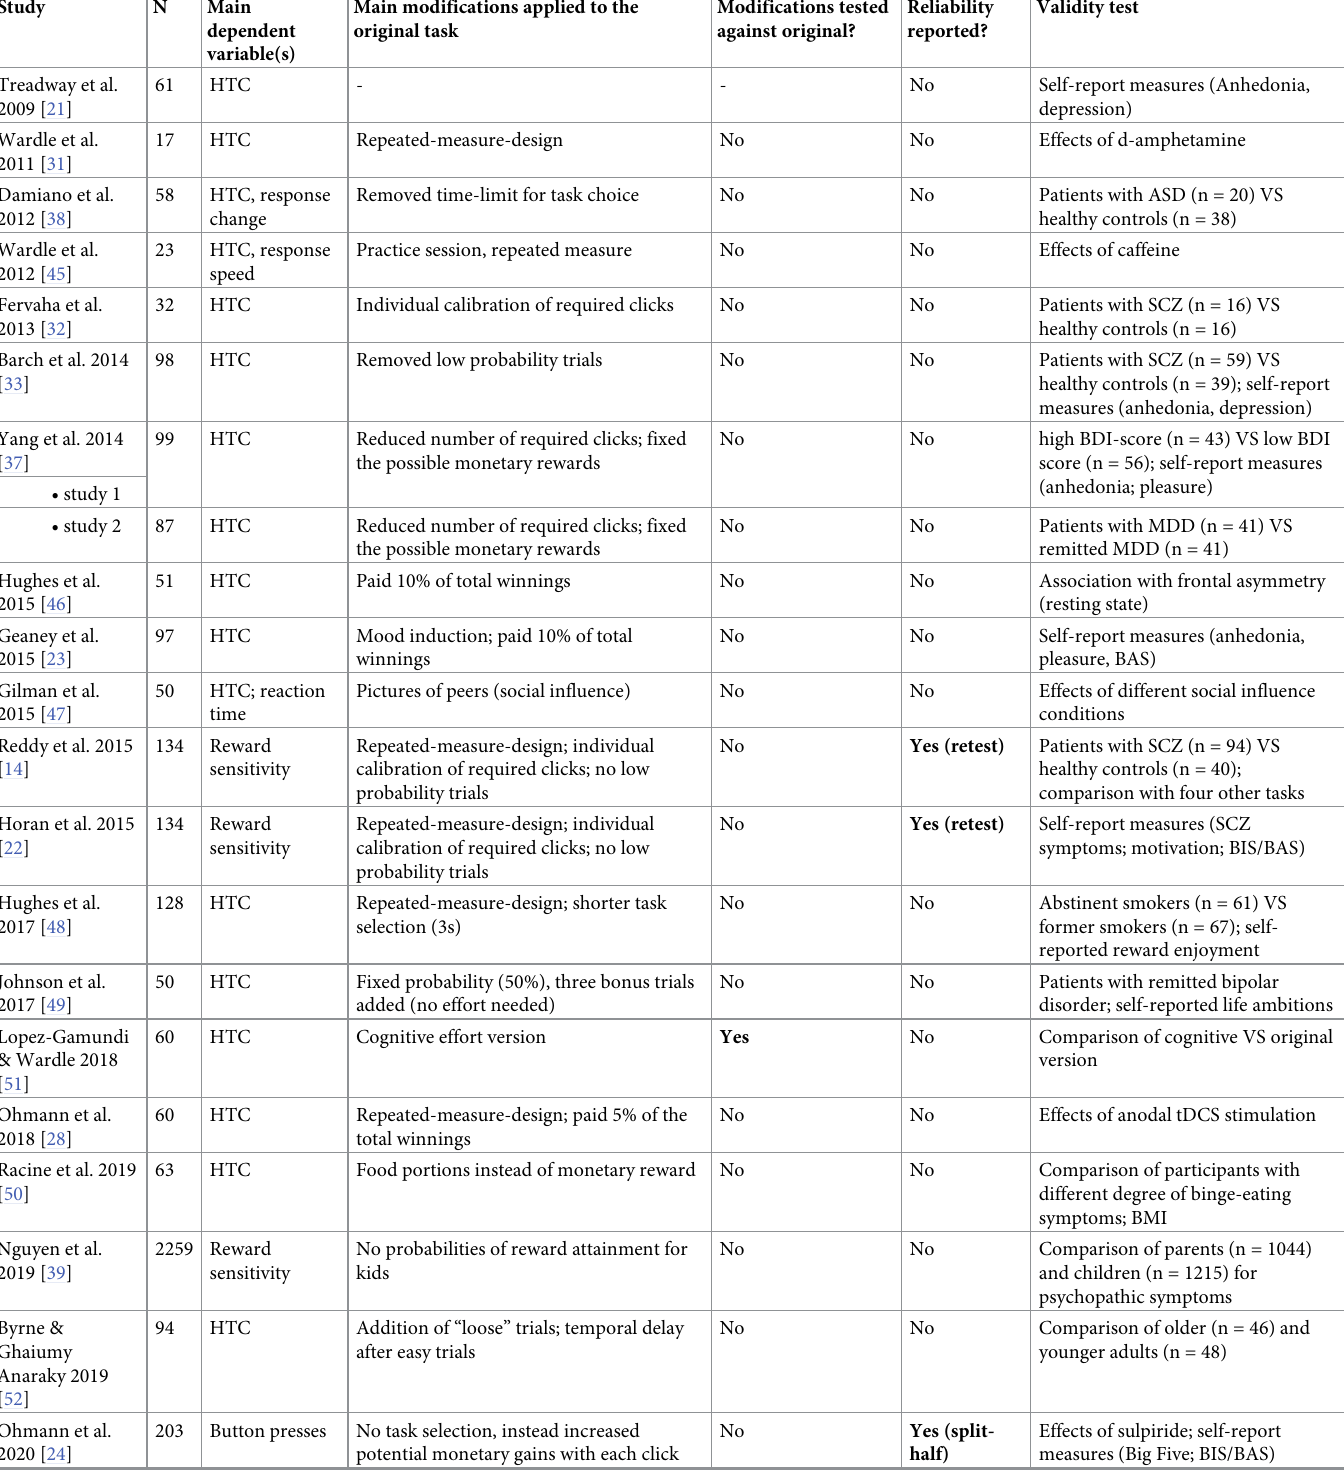
Table 1. An overview of selected studies using the EEfRT: Modifications, reliability, and validity (chronological